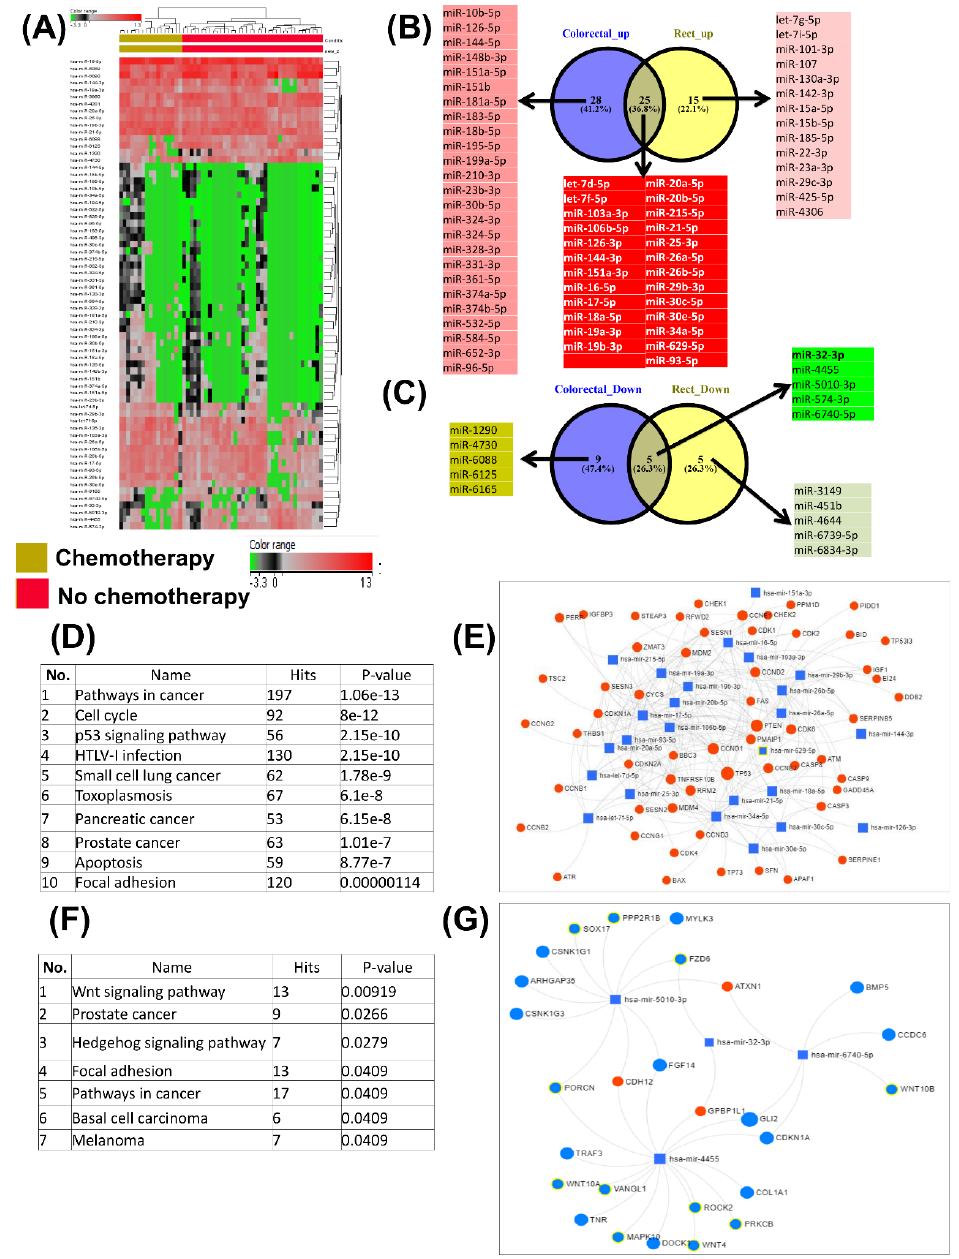
Figure 3. miRNA profile and pathway analysis affected by chemotherapy. ( A ) Heatmap detailing miRNA expression patterns from chemo-treated versus no chemotherapy plasma samples; ( B ) Venn diagram for the overexpressed miRNAs in colorectal and rectal cancer, emphasizing the common and specific signatures; ( C ) Venn diagram for the downregulated miRNAs in colorectal and rectal cancer; ( D ) cellular processes related to the target genes of the 25 most common overexpressed miRNA signatures in colorectal and rectal cancer. miRNA–mRNA integration was generated using miRNET and KEGG (Kyoto Encyclopedia of Genes and Genomes) classification of the target genes, based on statistical significance and strength of association; ( E ) miRNA–mRNA integration related to TP53 signaling; ( F ) cellular processes related to the target genes of the five most common downregulated miRNA signatures in colorectal and rectal cancer. ( G ) miRNA–mRNA integration was generated using miRNET and KEGG classification of the target genes based on statistical significance and strength of